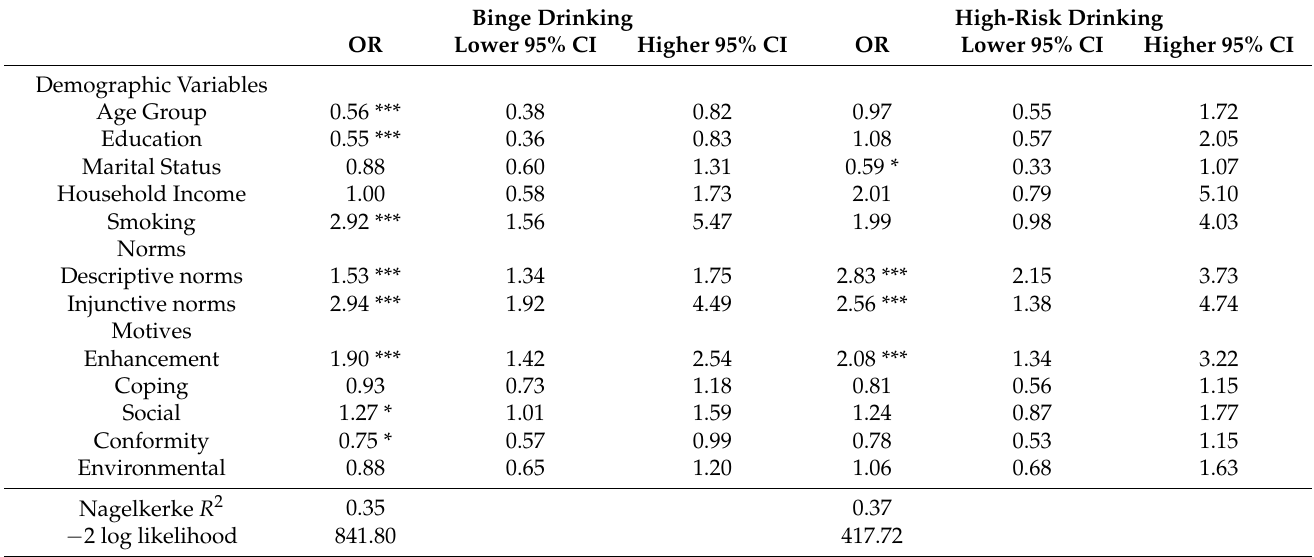
Table 5. Logistic regression analyses predicting binge drinking and high-risk drinking in